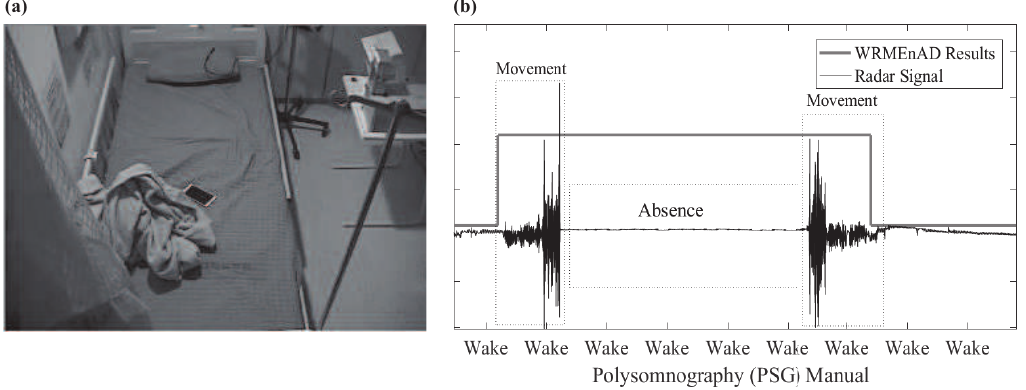
Figure 3. The wake-related movement existence and absence detection (WRMEnAD) algorithm: ( a ) absence of the patient during sleep; ( b ) performance of the WRMEnAD